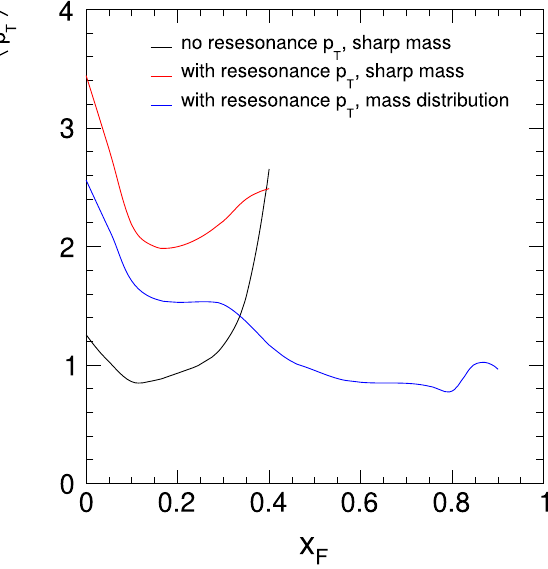
Fig. 155 dn / dx F for decay protons and pions as a function of x F